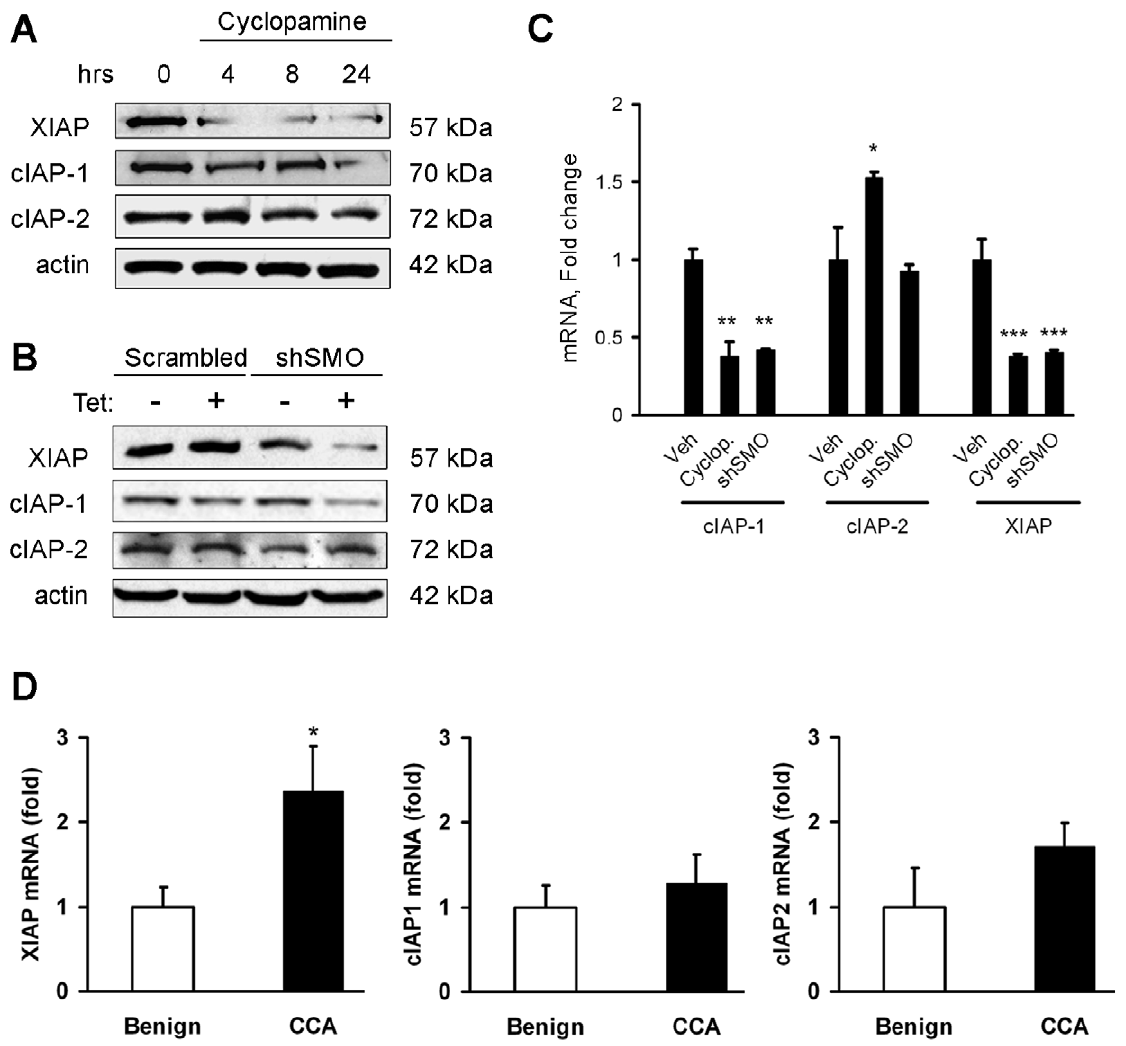
Figure 1. Smoothened inhibition down-regulates both cIAP-1 and XIAP expression. A, Cell lysates from KMCH cells treated with cyclopamine (5 m M) for the indicated times were immunoblotted for cIAP-1, cIAP-2 and XIAP. Actin was used as a loading control. B, KMCH cells were transfected with a tetracycline-inducible shRNA expression vector targeting Smoothened (shSMO) or a scrambled shRNA vector; shRNA expression was induced for 48 hours by treatment with tetracycline (1 mg/mL) followed by immunoblotting for cIAP-1, cIAP-2 and XIAP using whole cell lysates. C , Cells were treated with vehicle, cyclopamine (5 m M) for 24 hours, or transfected with shSMO as in panel B, then analyzed by real-time RT-PCR for cIAP-1 , cIAP-2 and XIAP using total RNA. D , Total RNA from tissue samples of either cholangiocarcinoma (CCA) or adjacent benign liver was used to assess XIAP, cIAP-1, and cIAP-2 mRNA expression, normalized to 18S and expressed as fold change from benign. Mean 6 SEM, *p , 0.05; **p , 0.01; ***p , 0.001 compared to